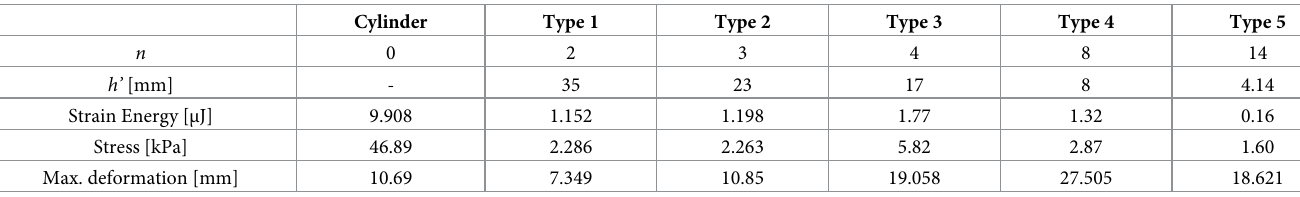
Table 2. Simulation results of the different types of skin.